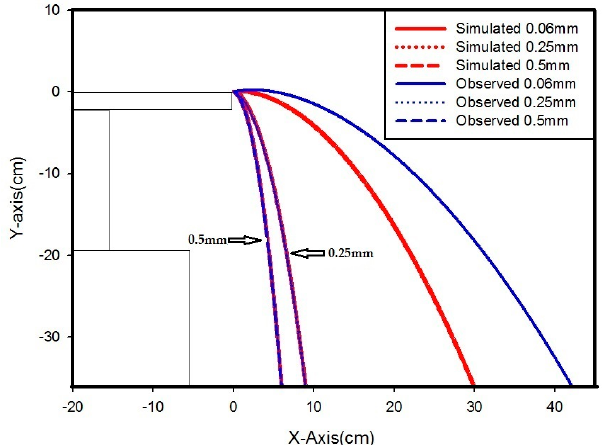
Figure 10. Comparison of conductive particle trajectory by observation vs. simulation. (Applied voltage (U): 20 kV, initial speed (v 0 ): 0.13 m · s − 1 , distance between two electrodes (L): 0.6 m).